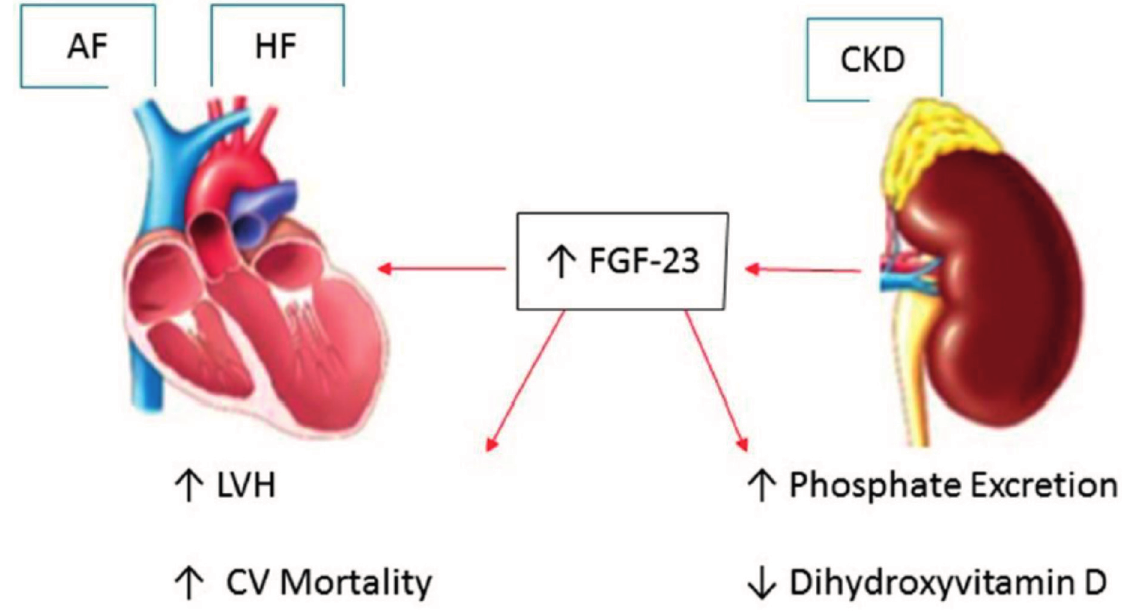
Figure 2. Fibroblast growth factor-23 (FGF-23): A key link between chronic kidney disease, atrial fibrillation and heart failure. CKD: chronic kidney disease; LVH: Left ventricular hypertrophy; CV: cardiovascular; ↑ up-regulation; ↓